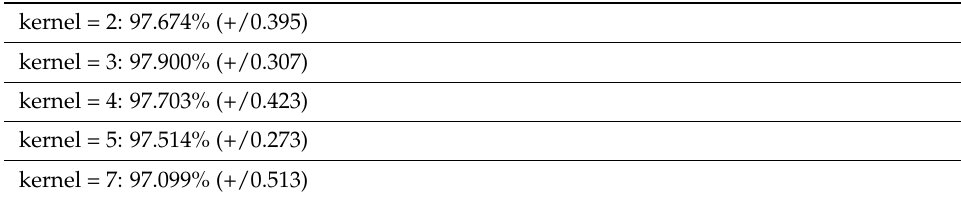
Table 2. Accuracy per kernel size for filter size